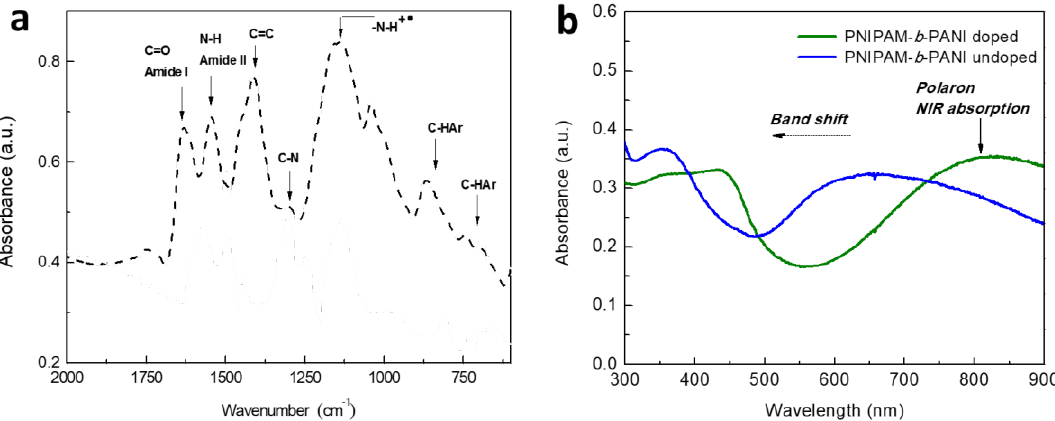
Figure 4. ( a ) FTIR spectrum for doped copolymer; ( b ) UV-Visible spectra in acidic and basic media of PNIPAM- b -PANI.